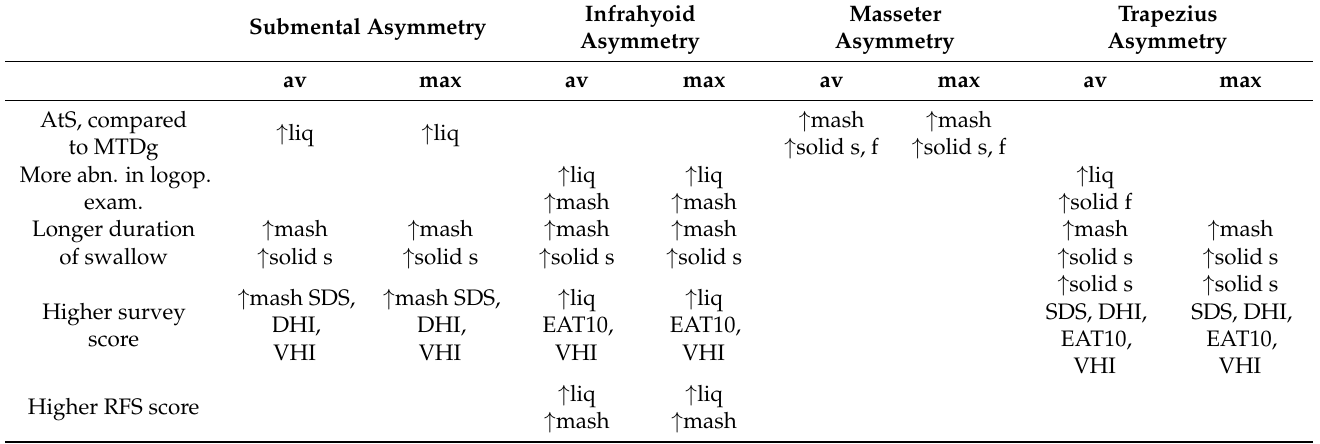
Table 4. The following table presents information in which situations increased asymmetry of muscles are observed for specific subpopulations. Muscle amplitude asymmetry values (average: av and maximum: max) during liquid (liq), mash and solid food swallowing and formation (solid s, solid f) are presented, depending on subgroup (patients with Atypical Swallowing (AtS), compared to patients with Muscle Tension Dysphagia (MTDg)), quantity of abnormalities in logopaedic examination, duration of swallowing and higher survey scores. Infrahyoid Submental Asymmetry Asymmetry